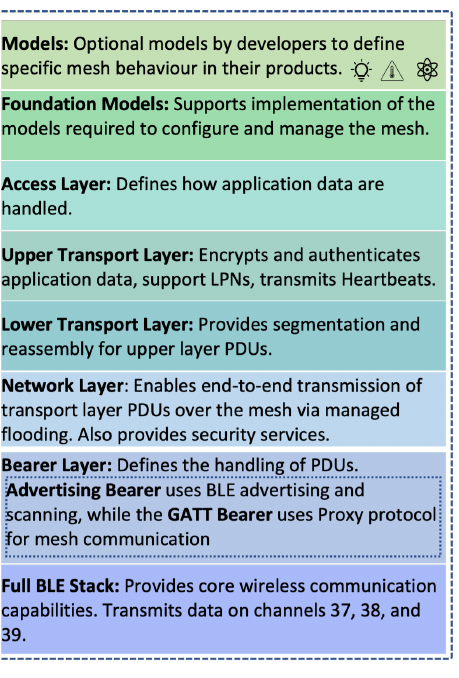
Figure 2. BT Mesh protocol